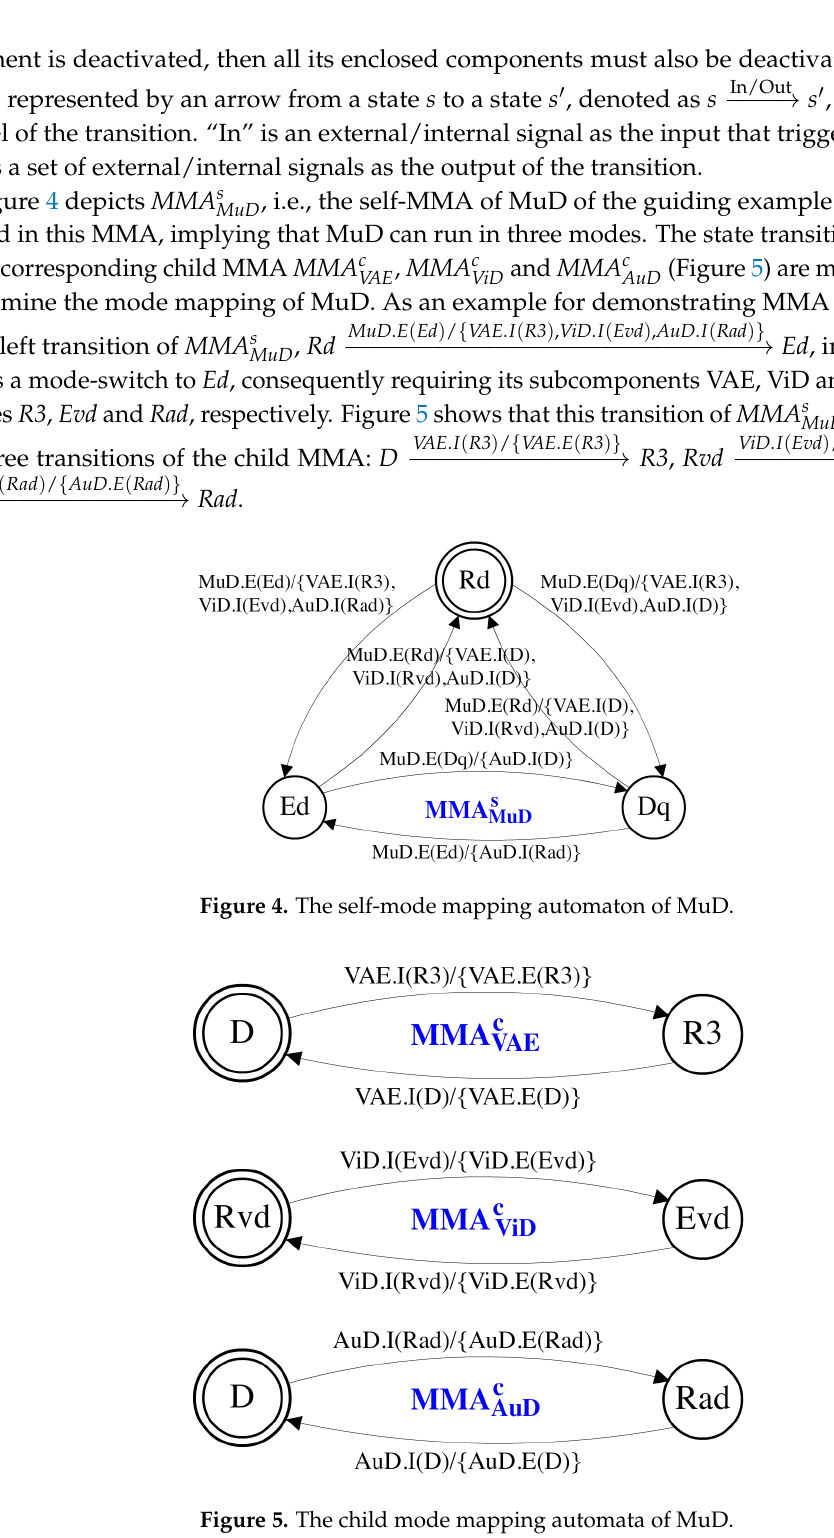
Figure 5. The child mode mapping automata of